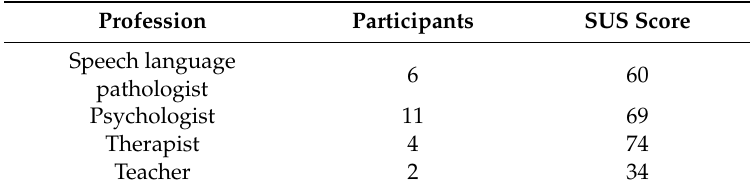
Table 6. Table with the average score per group.